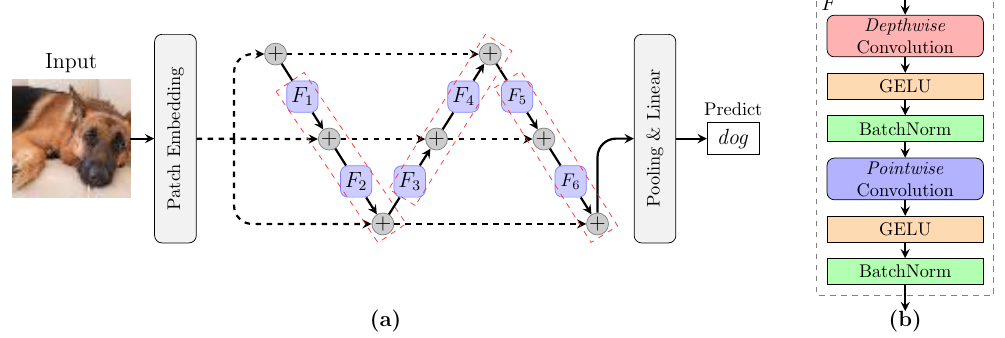
Figure 4. ( a ) Architecture of the FoldNet model. FoldNet starts with the patch embedding layer, continues with multiple folding blocks shown by the red-dashed rectangles, followed by the pooling and the linear softmax classifier. Here, the depth n = 6, the folding length d = 3, and the number of folding blocks equals n / ( d − 1 ) = 3. ( b ) Details of each non-linear transformation F i , including a depthwise convolution followed by an GELU activation and a post-activation BatchNorm. After that followed a pointwise convolution, another GELU activation, and another post-activation